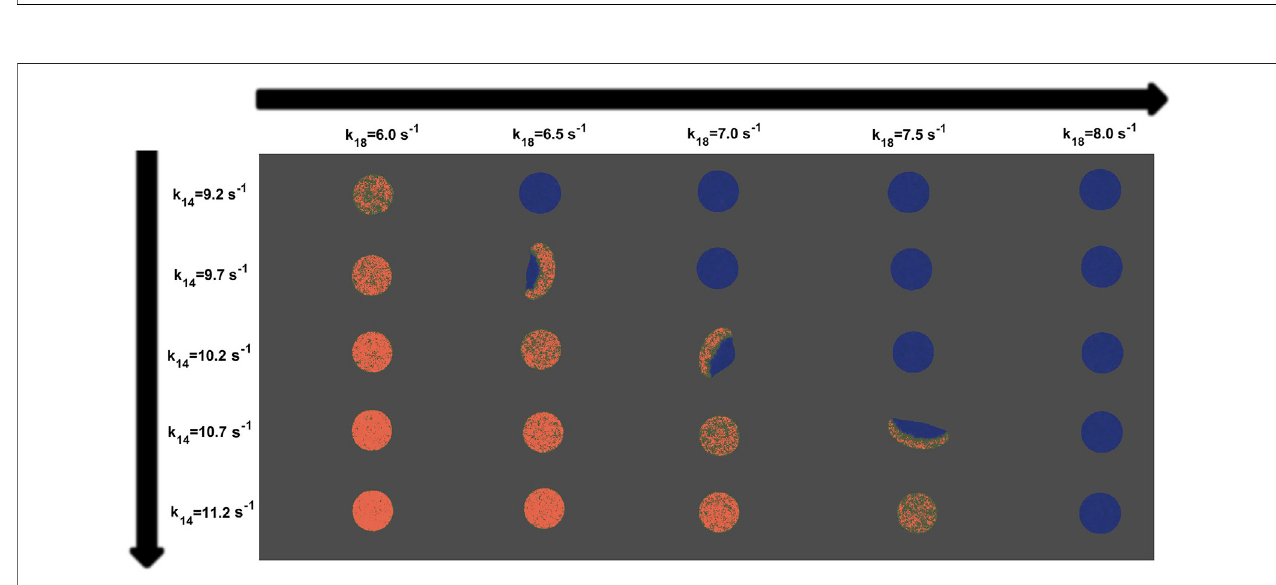
FIGURE 3 | Hysteresis curves of the deterministic model ( σ R = 0 and σ P = 0). The value of the homogeneous solution of P is shown as function of the parameter increasing and, subsequently, decreasing of k 14 , keeping k 18 = 7 s − 1 (A) and k 18 keeping k 14 = 10.2 s − 1 (B) . Increase and decrease of the both parameters are done by steps of 0.05 s − 1 and, after each step, permitting to relax to the new solution for 180 s.